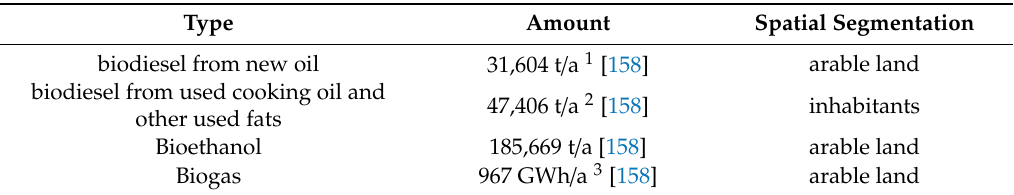
Table 9. Current production of bio fuels and biogas using biomass from